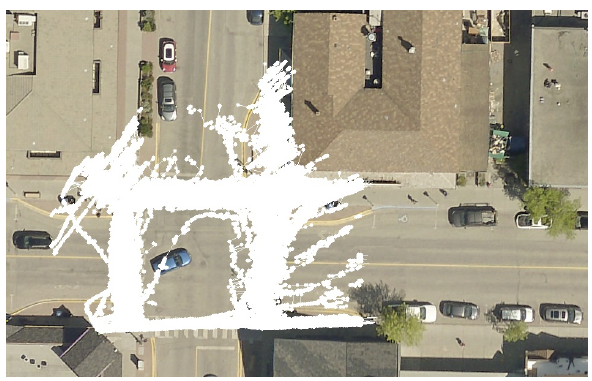
Figure 7. Aggregated pedestrian trajectories